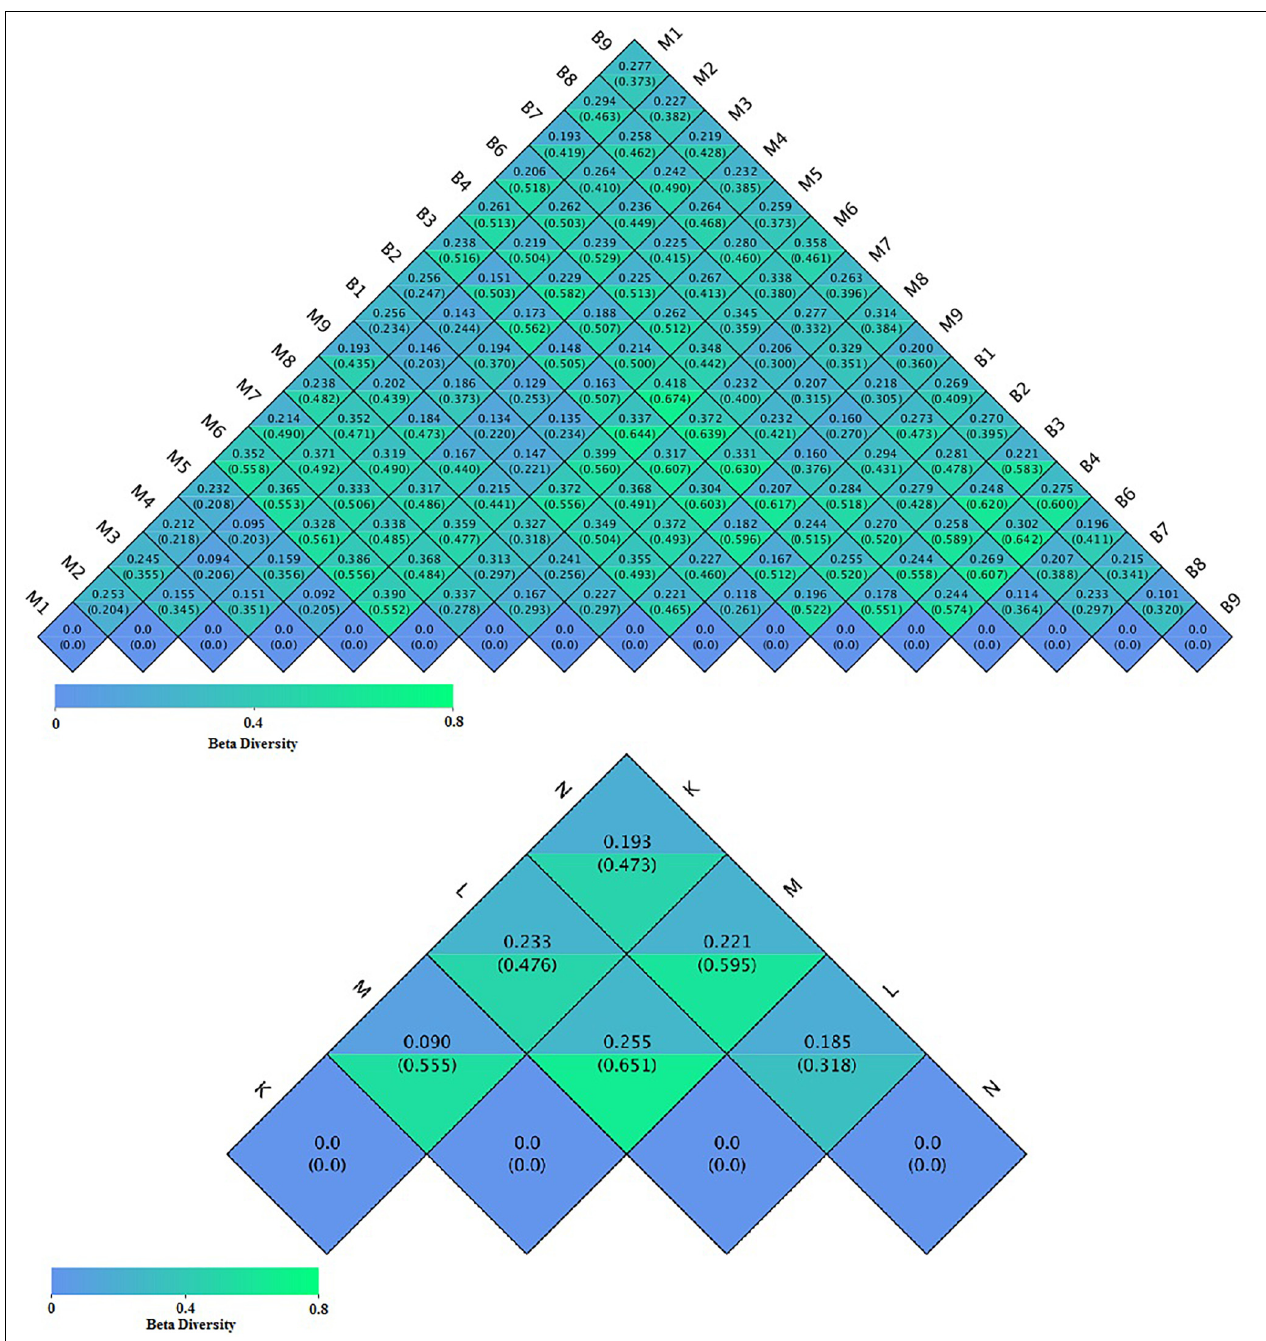
FIGURE 6 | Heatmap of the beta-diversity of microbiota. The numbers in the grid blocks represent the dissimilarity coefficients between fecal samples. The top number in each block represents the weighted Unifrac distance and the bottom number represents the unweighted Unifrac distance. K, low-altitude mouflon; L, high-altitude mouflon; M, low-altitude blue sheep; N, high-altitude blue